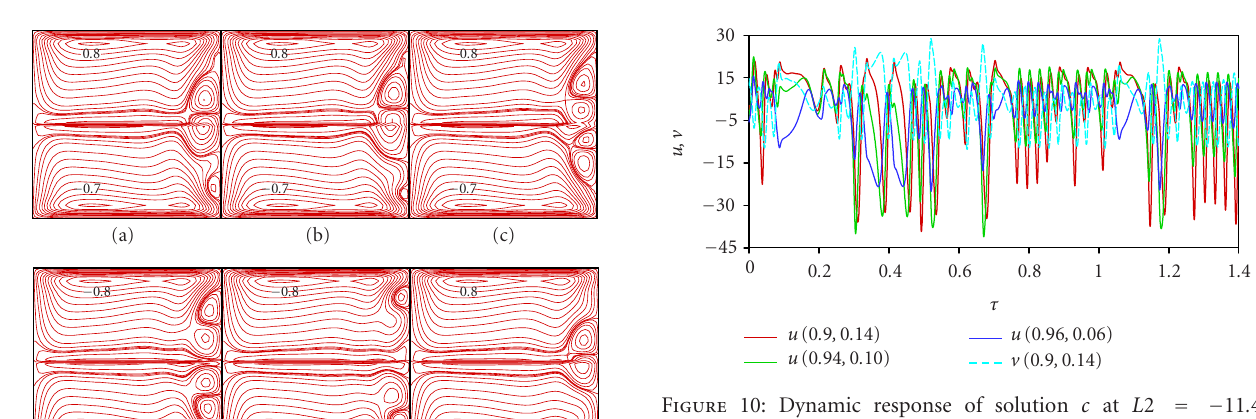
Figure 10: Dynamic response of solution c at L 2 = − 11 . 4 (Figure 2c) to finite random disturbance: chaotic oscillations ( σ = 0 . 02, Pr = 0 . 7, Dk = 300, and L 1 = 28). for all velocity components, pressure, and temperature at all points in the flow domain. At L 2 = − 10 . 25, a second fre- quency f 2 appears (Figures 11b, 12b). f 2 is a half of f 1 , indi- cating the subharmonic bifurcation. A second